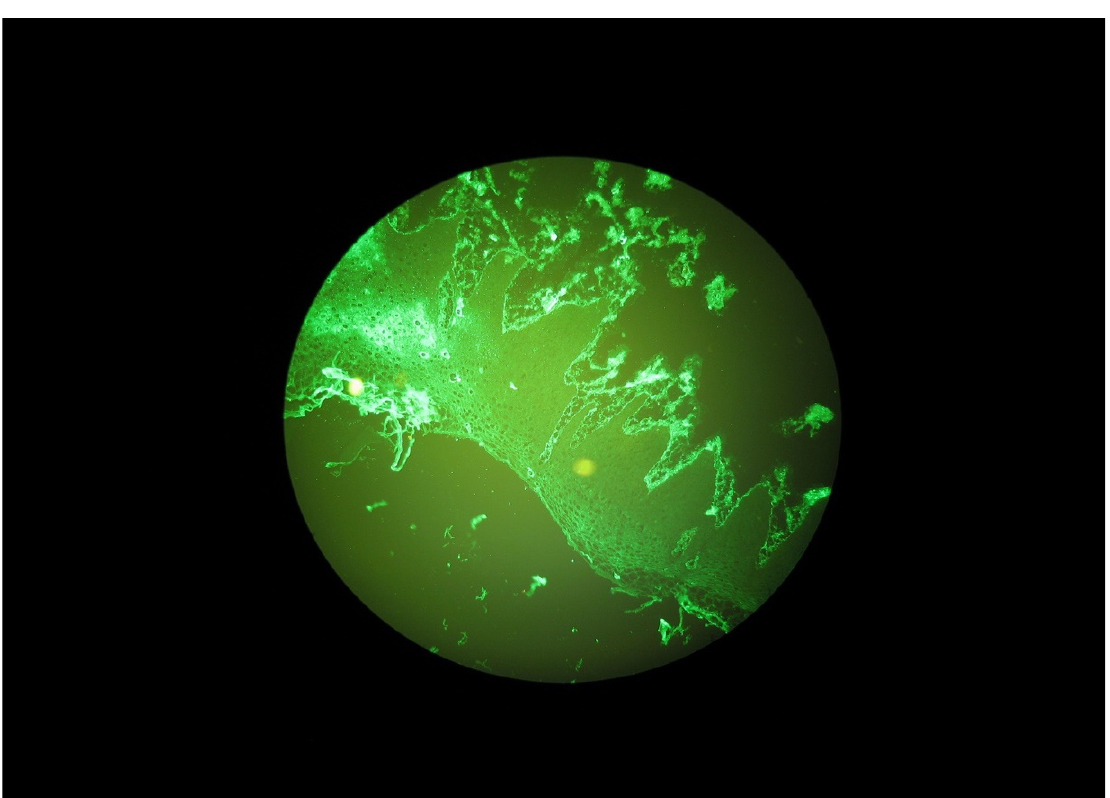
Figure 3. Granular IgA deposits along the basal membrane of the oral mucosa in a DH patient.